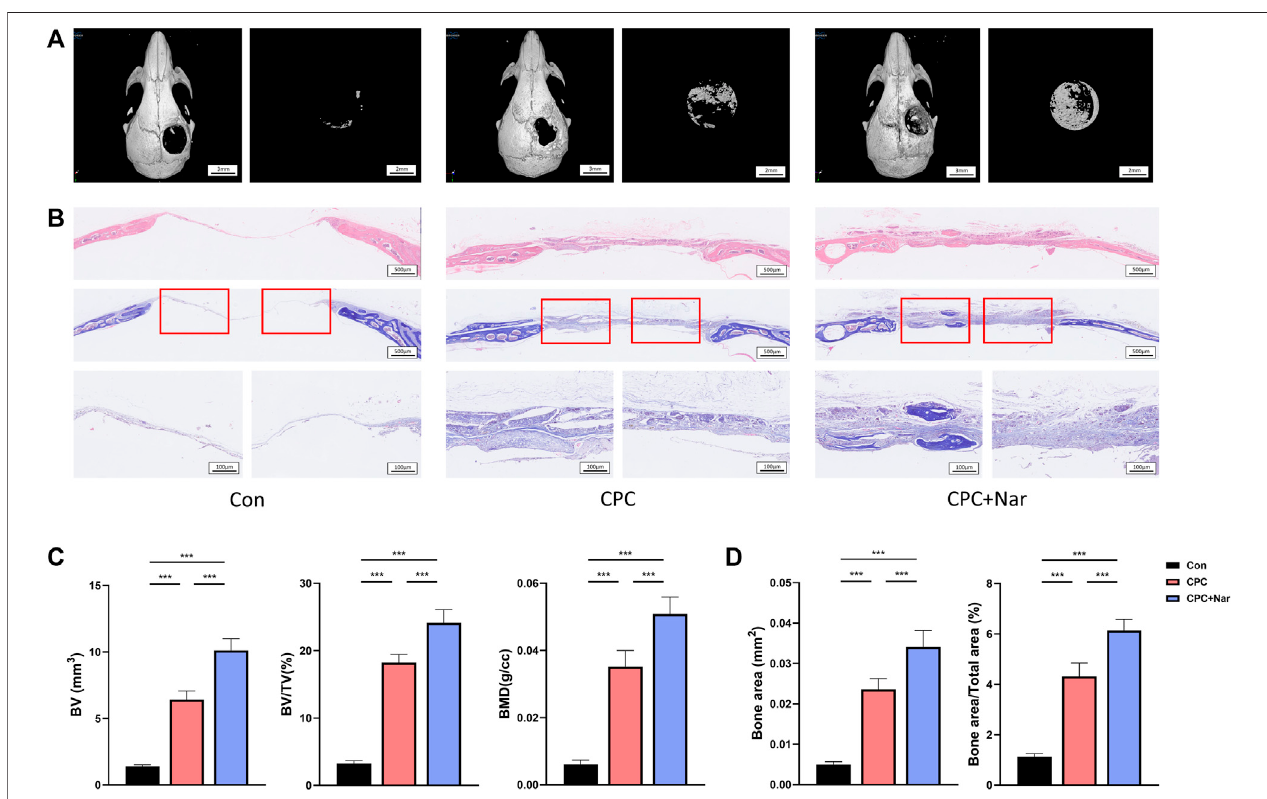
FIGURE8| Naringeninpromotesthehealingofcalvarialdefect. (A) Representative μ CTanalysisofthecalvarialdefects. (B) HEstainingandMassonstainingofthe calvarial defects. (C) Calculations ofbone volume (BV), BV/TV, and BMD of new bone in the calvarial defects. (D) Quanti fi cation of bone area and bone area/total areaof new bone in the calvarial defects from Masson staining. n = 5 replicates per group in all panels. Data are expressed as mean ± SD. * p < 0.05; ** p < 0.01; *** p < 0.001.